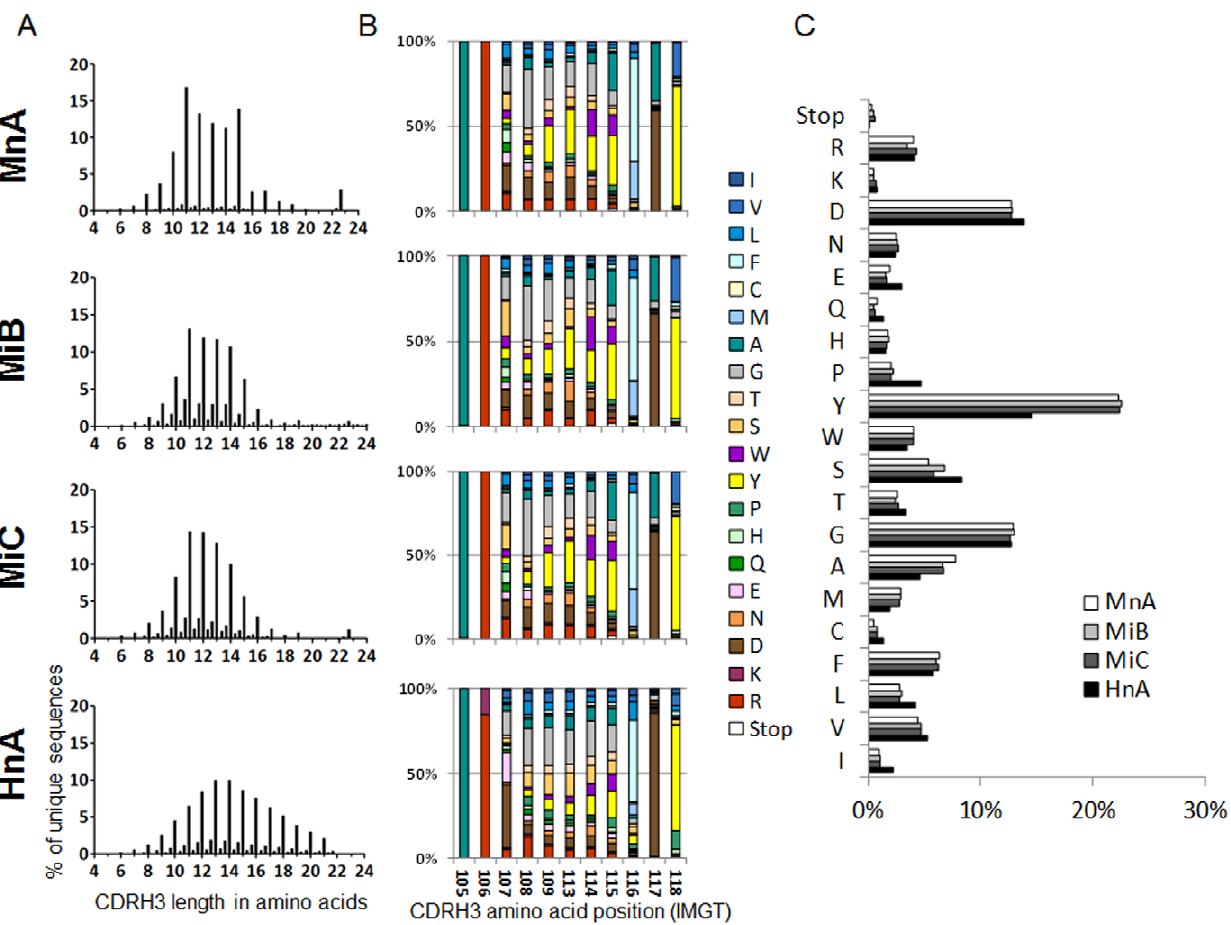
Figure 2. Characterization by NGS of captured murine and human CDRH3 repertoires. (A) Length profile of CDRH3 represented as the percentage of unique CDRH3 in function of their length in amino acids (AA). The minor peaks in between integers correspond to sequences where a frame shift occurred. (B) AA composition profile of unique CDRH3 of 11 AA, the most common length in murine diversity according to (A). For each position in the CDRH3, the percentage of AA was defined and illustrated according to a color code. IMGT numbering was followed to refer to AA positions. (C) AA composition profile of unique CDRH3 all lengths considered. The few stop codons found are likely due to cloning or NGS errors.